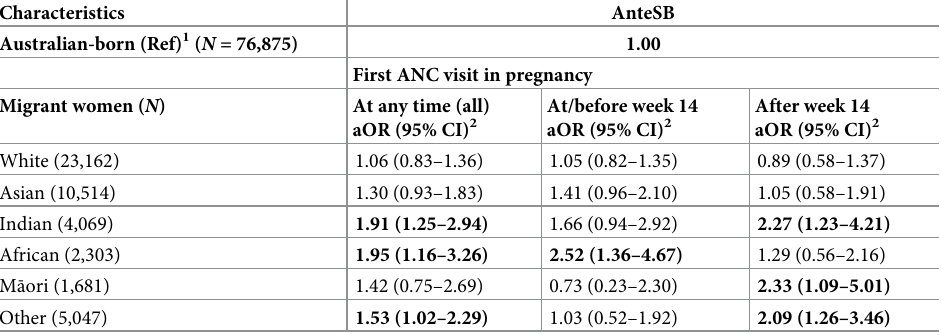
Table 5. Comparison of the odds of AnteSB in migrant women, stratified by ethnicity and timing of first ANC visit, with Australian-born women (2010–2013).